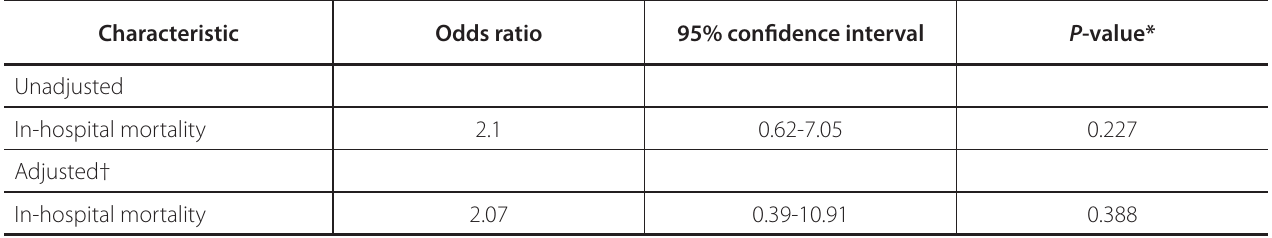
Table 3 . The unadjusted and adjusted regression model for the predictive effect of hemoglobin A1c on in-hospital